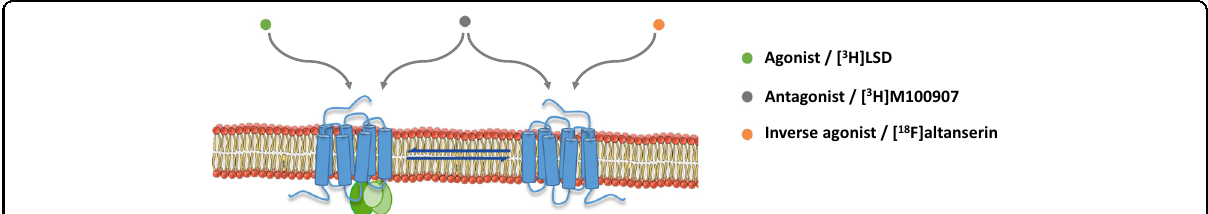
Fig. 1 Conformational states of the 5-HT 2A R. The receptor conformation coupled to G-protein signalling pathways represents the functional state and is preferentially identi fi ed by agonist radioligands such as [ 3 H]LSD. The inactive conformation of the 5-HT 2A R, which is uncoupled from G proteins, is preferentially labelled by inverse agonist radioligands such as [ 18 F]altanserin. Active and inactive conformations are interchangeable states that stay in equilibrium 17 . Antagonist radioligands, such as [ 3 H]MDL100907, bind both receptor conformations and, therefore, do not distinguish between functional and non-functional